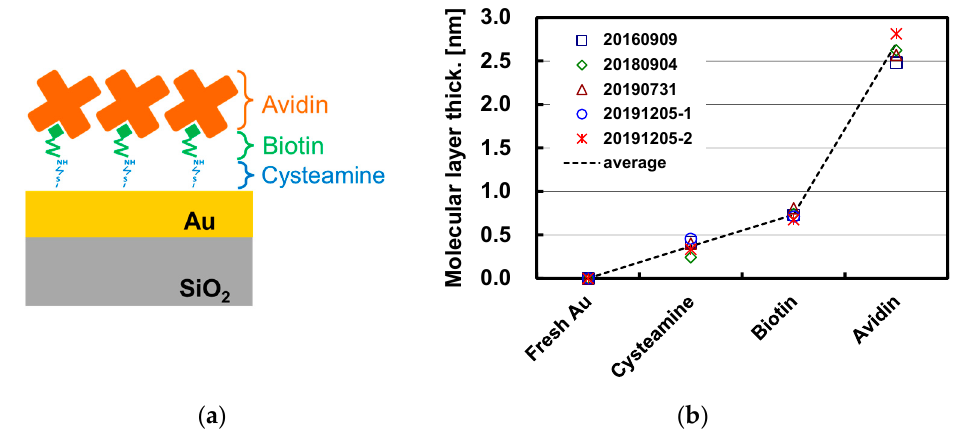
Figure 14. ( a ) Schematic of avidin–biotin complex and cysteamine immobilized on flat Au surface; ( b ) molecular layer thickness measured by ellipsometry with 632.7 nm light and the assumed layer refractive index of 1.5.